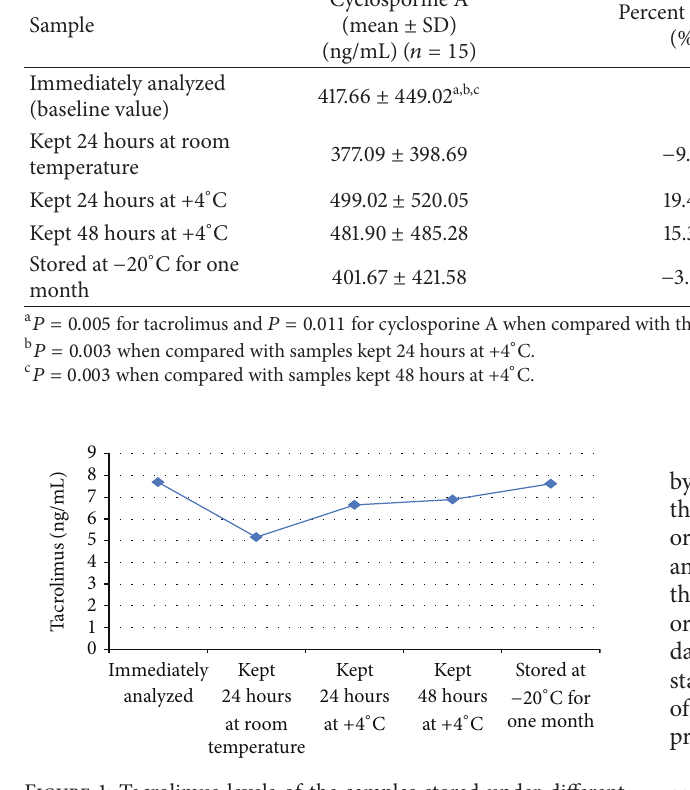
Figure 1: Tacrolimus levels of the samples stored under different storage conditions.